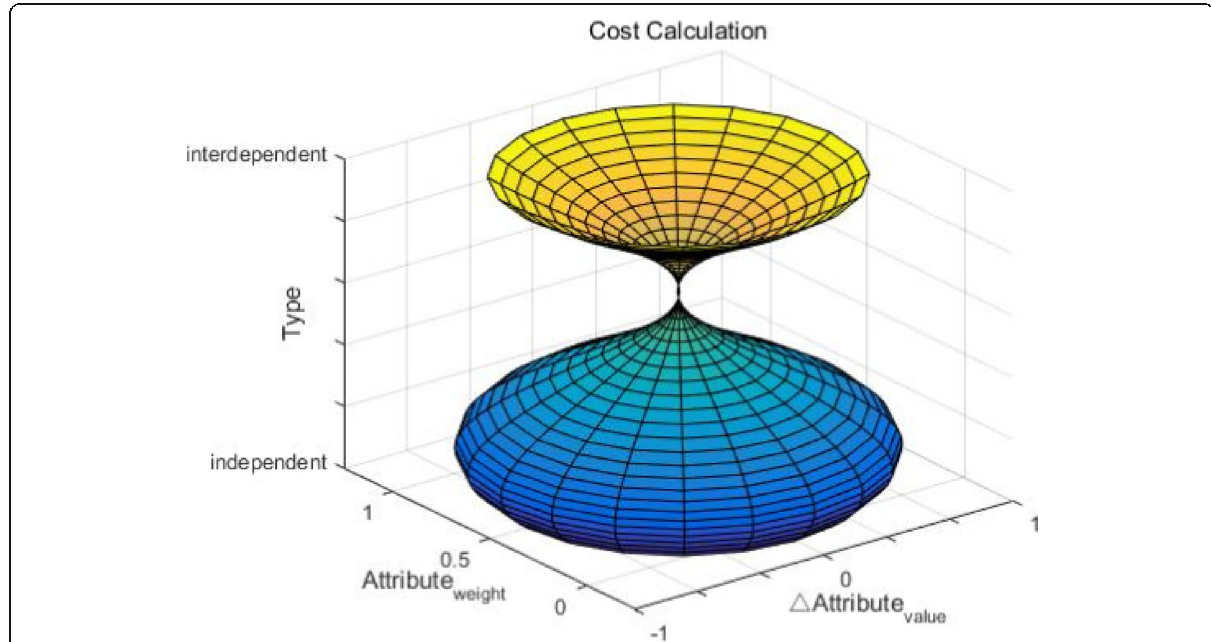
Fig. 10 Cost calculation affects the type of